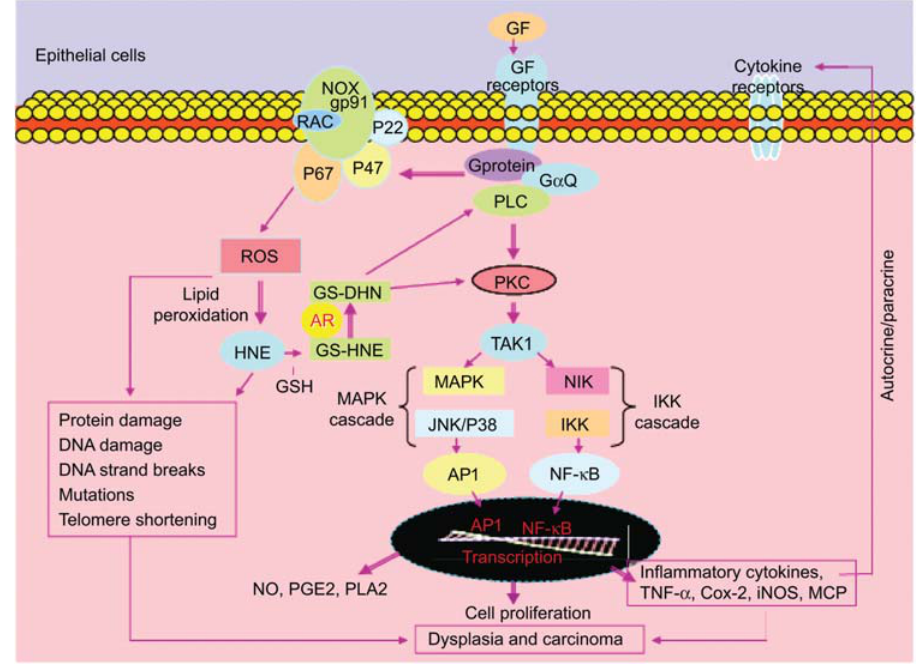
Figure 4 Aldose reductase mediates growth factor-induced inflammatory signals. Growth factor stimulated oxidative stress generates lipid peroxidation-derived lipid aldehydes such as highly toxic HNE. HNE being highly electrophilic conjugates with cellular GSH to form GS-HNE. AR catalyzes the reduction of GS-HNE to GS-DHN. The GS-DHN has been shown to mediate oxidative stress signals upstream to PLC/PKC leading to activation of transcription factors such as NF- k B and AP1 which transcribes inflammatory genes. The inflammatory proteins propagate the carcinogenic signals and cause tissue damage, dysfunction leading to uncontrolled tumor